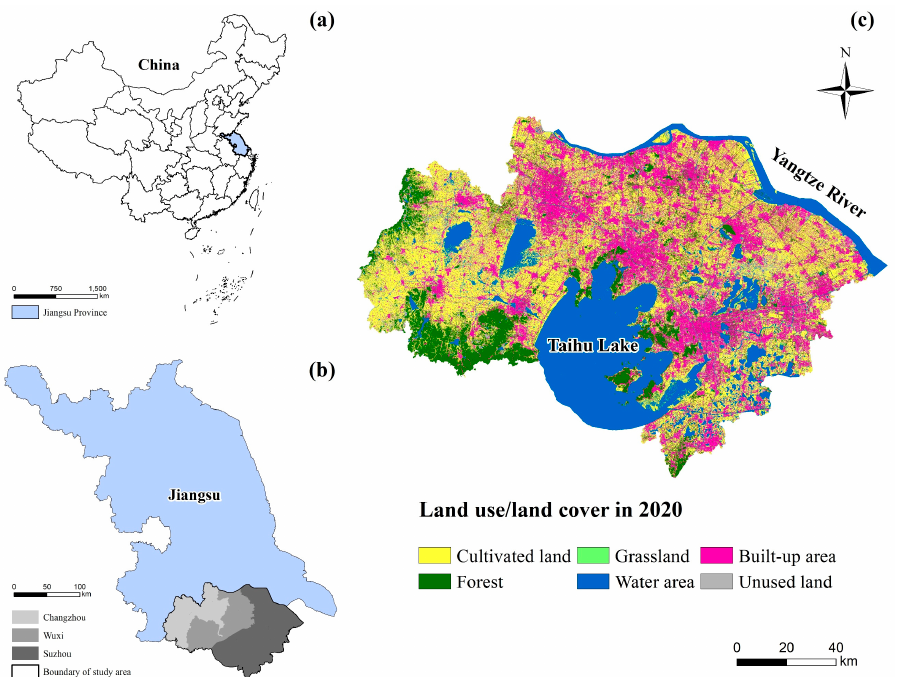
Figure 1. ( a ) The location of Jiangsu province in China; ( b ) the location of the Su-Xi-Chang region in Jiangsu province; ( c ) the land use/land cover (LULC) pattern of the Su-Xi-Chang region in 2020.